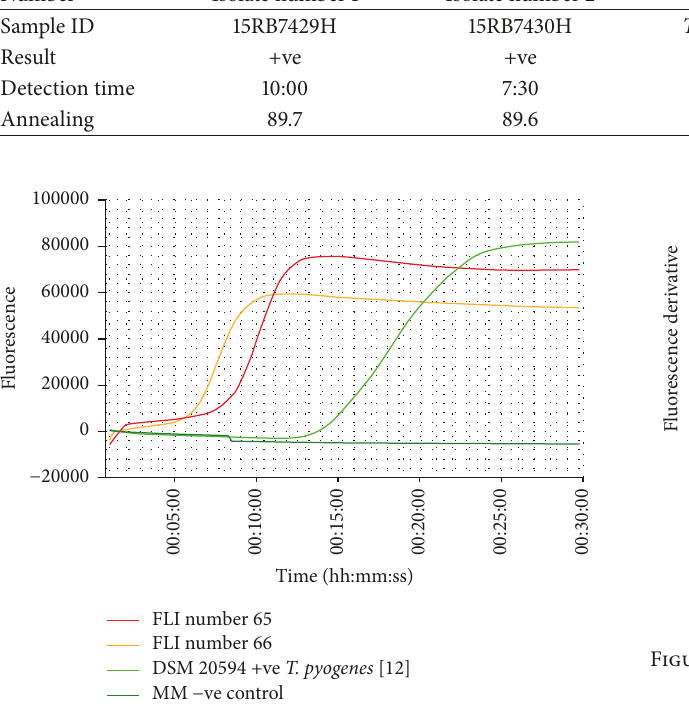
Figure1:LoopamplificationsignaloftheLAMPproductsofthetwo T. pyogenes isolates, the reference strain T. pyogenes DSM 20594, and the negative control.